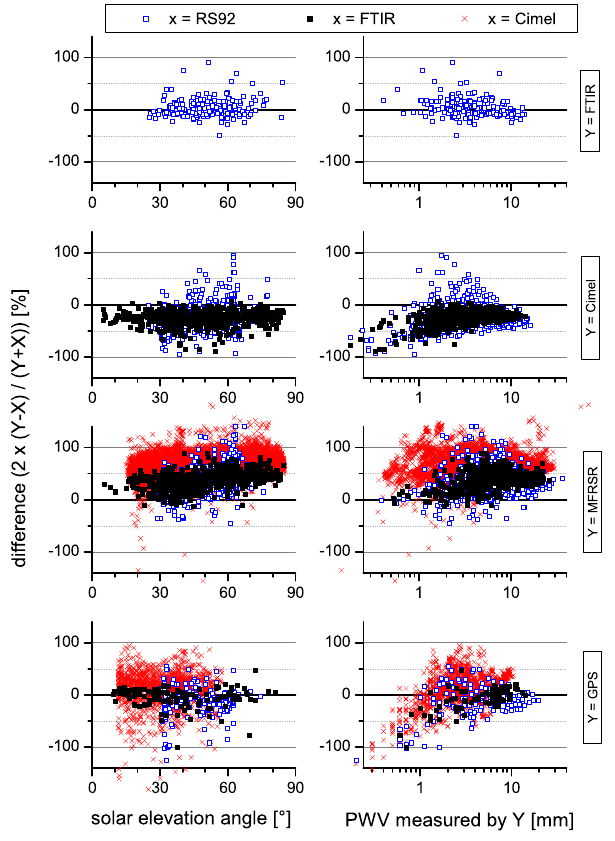
Fig. 6. Characterisation of PWV differences (2 × Y − X RS92 (open blue squares), FTIR (solid black squares), and Cimel (red crosses), and with Y: FTIR (top panels), Cimel (second row of panels), MFRSR (third row of panels), GPS (bottom panels). Left panels: difference versus solar elevation angle; right panels: differ- ence versus PWV of